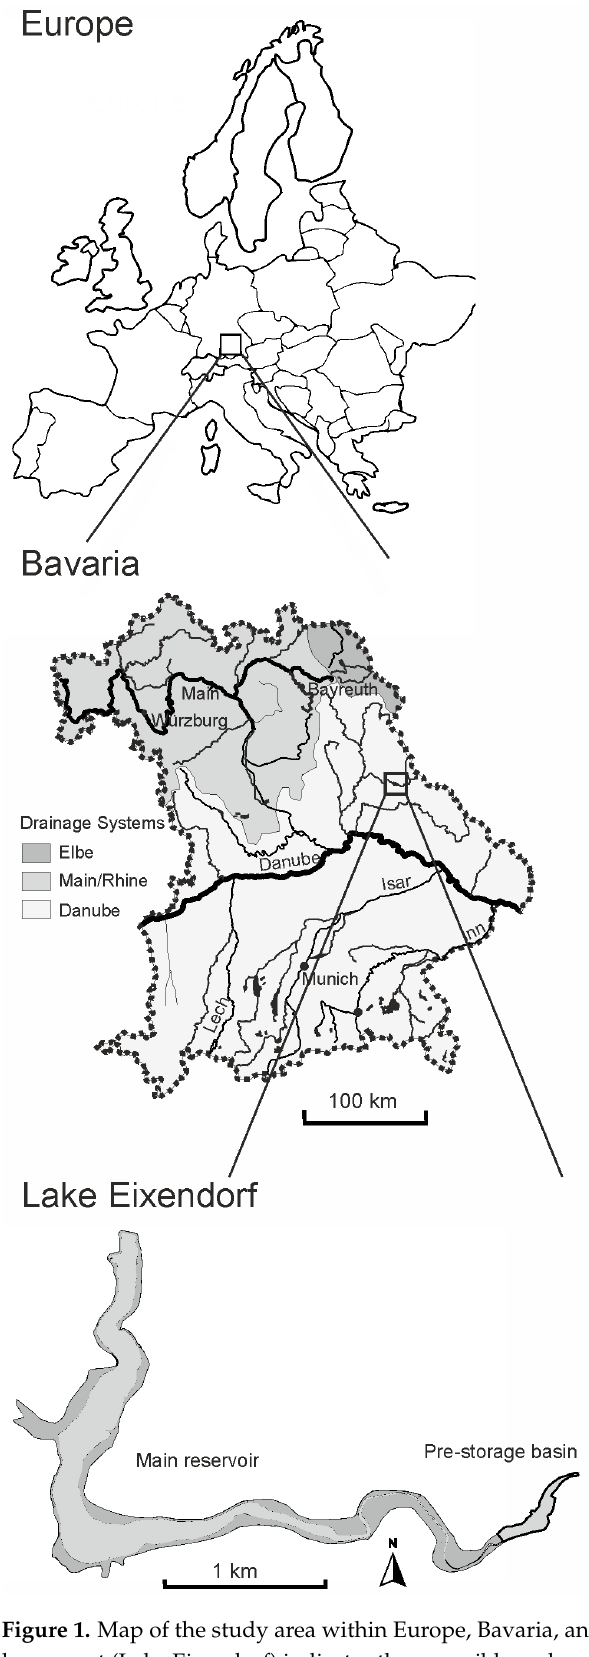
Figure 1. Map of the study area within Europe, Bavaria, and Lake Eixendorf. Dark grey area in the lower part (Lake Eixendorf) indicates the accessible and sampled area during the dewatering.